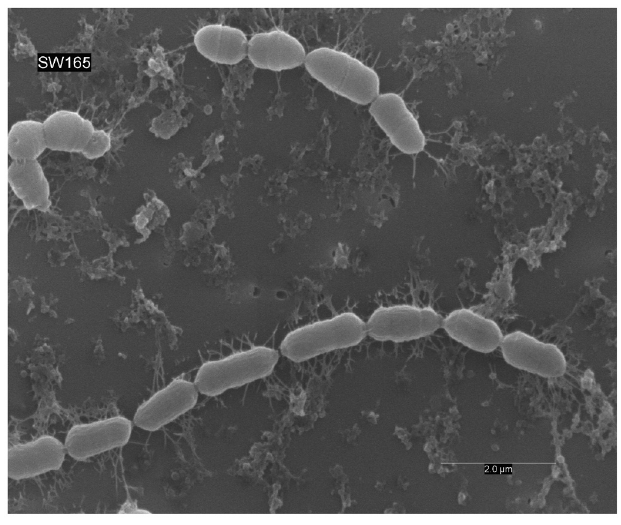
Figure 2. Scanning electron micrograph of O. lakotia SW165 T . Cells were anaerobically cultured for 24 hours at 37°C in BHI-M medium. Bar, 2 μm; uncropped/unedited image.